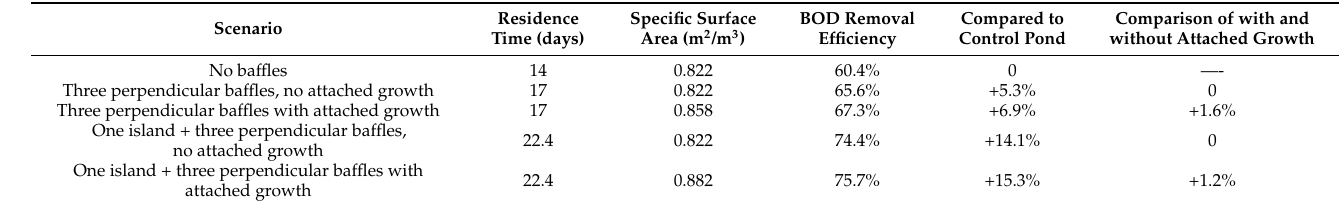
Table 5. The application of kinetic model to estimate BOD reduction of different